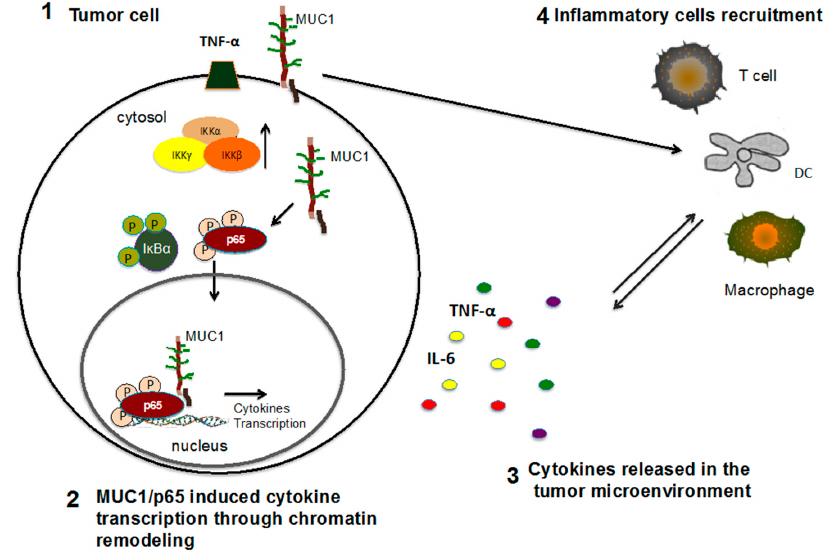
Figure 3. Model of MUC1 role in the tumor microenviroment. ( 1 ) Upon inflammatory stimuli, MUC1 induces activation of nuclear factor kappa B (NF- κ B) members and binds phopsho-p65; ( 2 ) MUC1/phospho-p65 complex translocates to the nucleus and associates with the promoter of pro-inflammatory cytokines, such as interleukin 6 (IL-6) and tumor necrosis factor alpha (TNF- α ), promoting their transcription and expression; ( 3 ) Secretion of inflammatory cytokines recruits inflammatory cells, including myeloid cells and neutrophils, into the tumor site; ( 4 ) Inflammatory cells are a further source for pro-inflammatory and pro-tumorigenic cytokines that enhance tumor growth and progression. DC: dendritic cells; IKK: I κ B kinase; I κ B: phospho-inhibitor of kappa